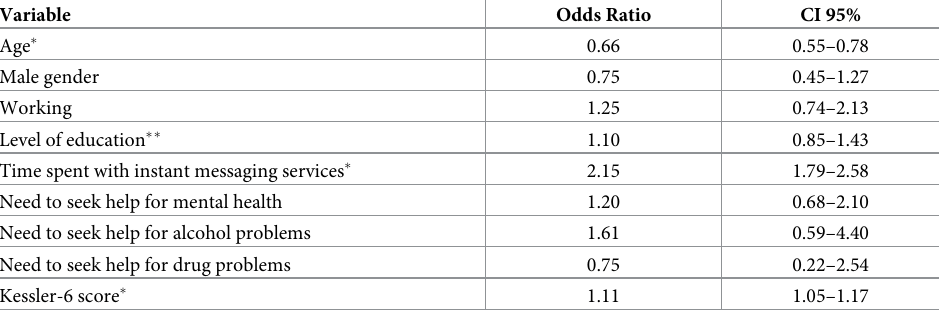
Table 3. Logistic regression analyses, associations with problematic use of social media as the dependent variable (n = 1,863). Analyses after exclusion of 139 cases with non-complete for included variables.